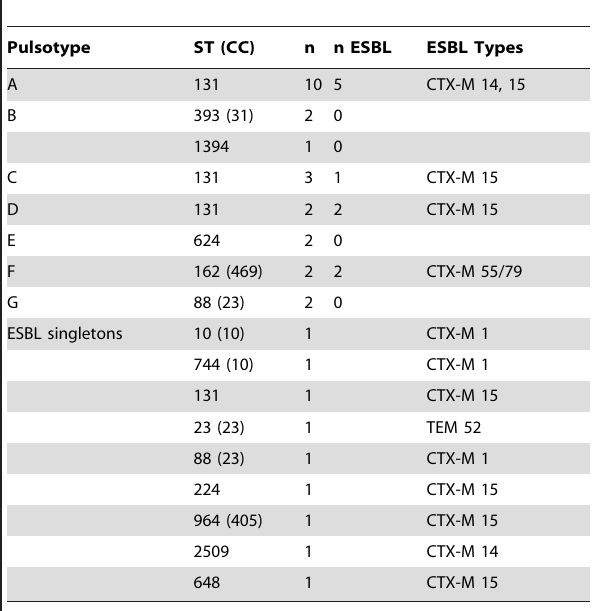
Table 3. Pulsotypes and STs of multi drug resistant and/or ESBL producing isolates.